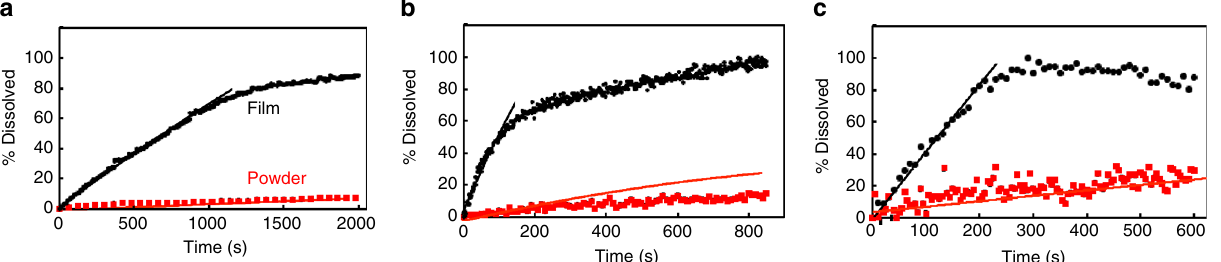
Fig. 7 Dissolution pro fi les of fi lms and powders. Dissolution pro fi les of fi lms and original powders ( dotted line — experimental values. Solid lines — theoretical prediction according to Eq. 2 for fi lm and Eq. 3 for powder): ( a ) fl uorescein in deionized water — 23 μ g weight. b Ibuprofen in aqueous HCl buffer pH 1.2 —